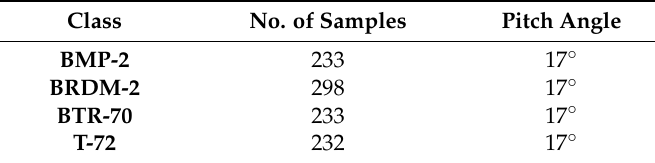
Table 5. Training set under EOC2.